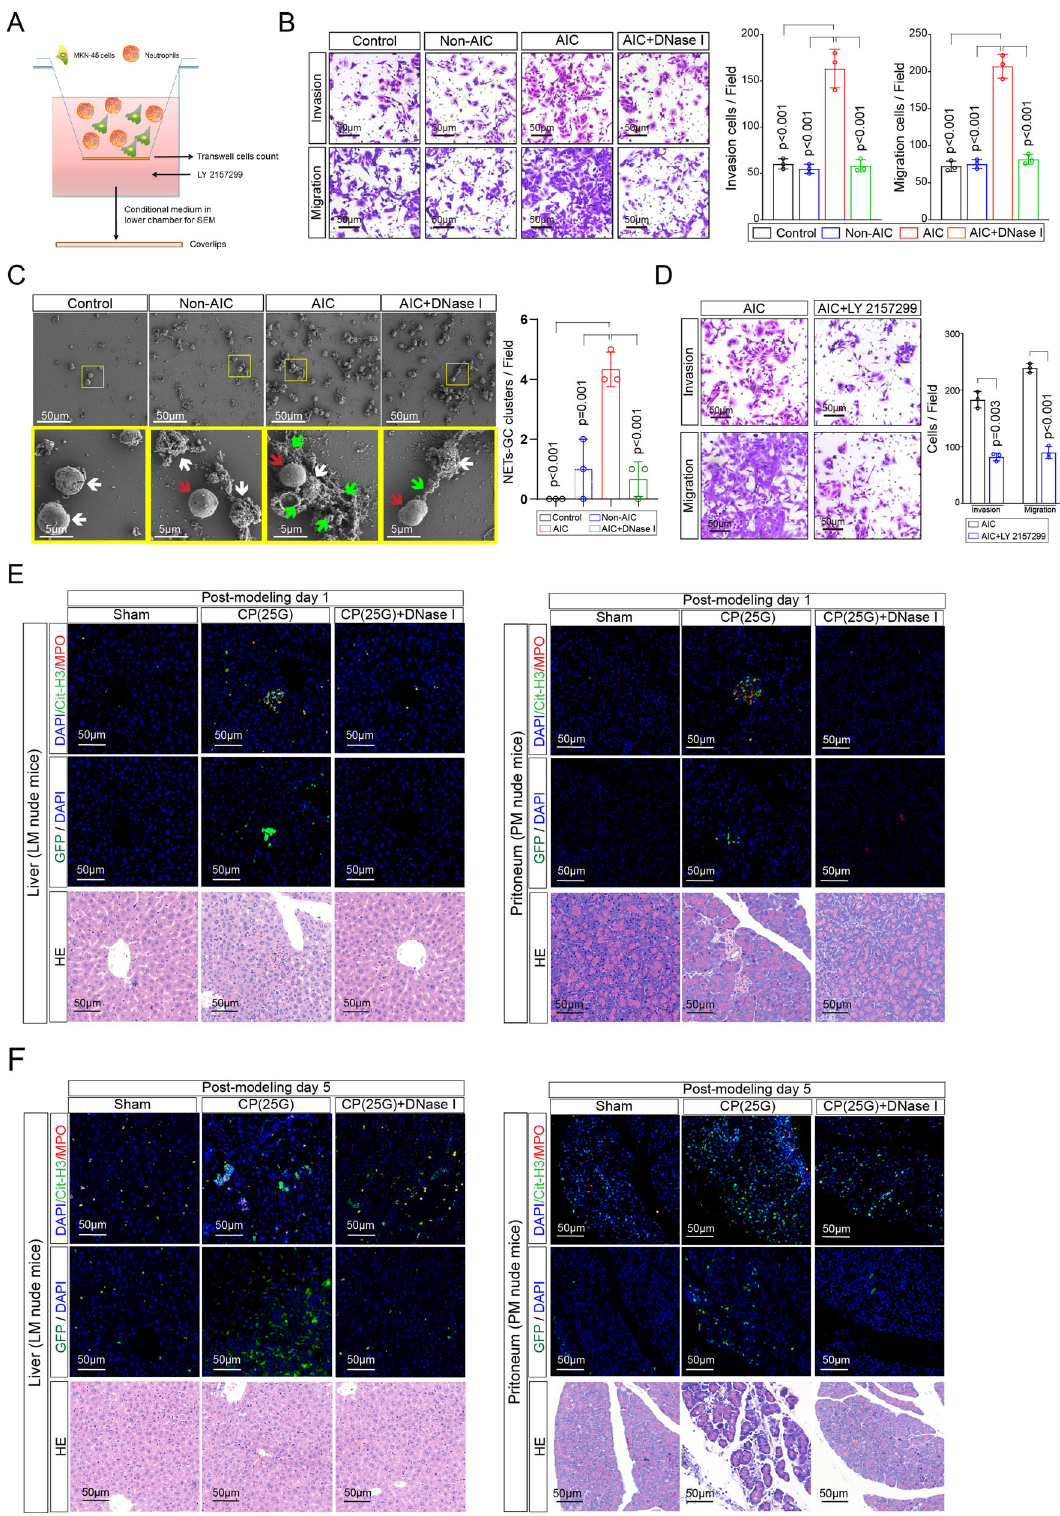
Since depleting neutrophils or inhibiting NETs are not clinically feasible due to risk of infection or sepsis, our fi ndings that TGF- β signaling may be targeted therapeutically to reduce metastasis in the context of metastasis-supporting NETs-GC clusters provides the prospect to mitigate the adverse oncologic consequences in locally advanced GC patients experiencing postoperative